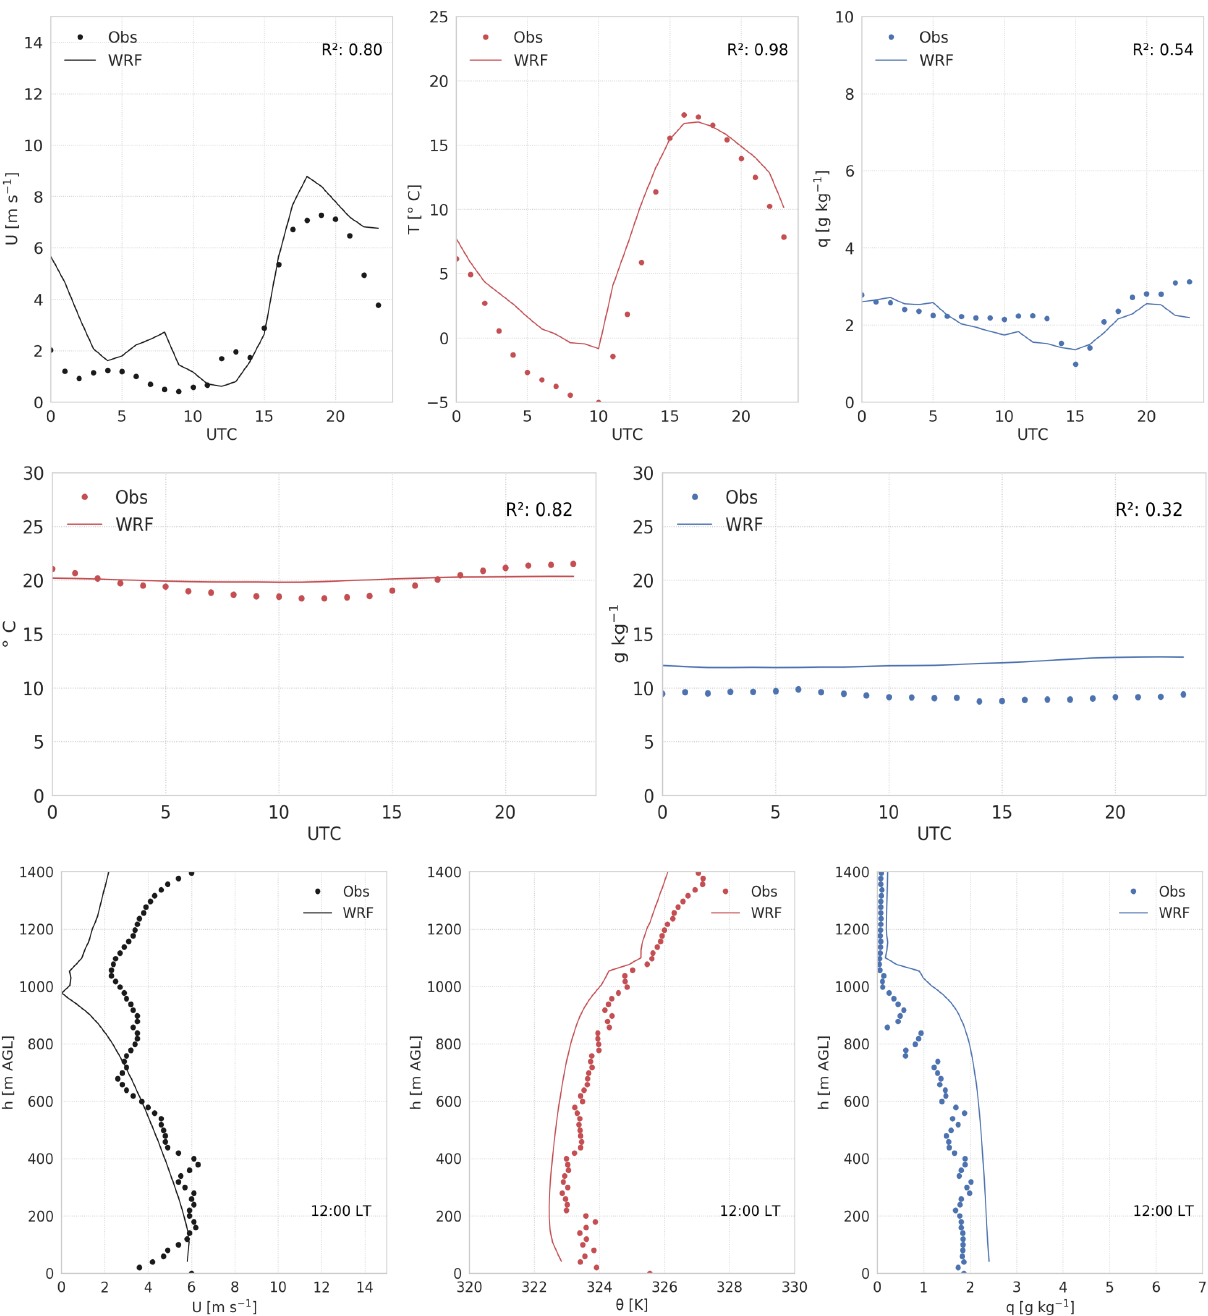
Figure A1. First row: diurnal average (13–24 November 2018) of 2m U , T and q of WRF domain D04 and CEAZA MET station. Second row: diurnal average (13–24 November 2018) of 2m T and q of WRF domain D02 and Diego Aracena airport MET station. Vertical profiles of U , θ and q of WRF domain D04 and radiosounding launched during the E-DATA on 22 November 2018 at 12:00LT over the desert.